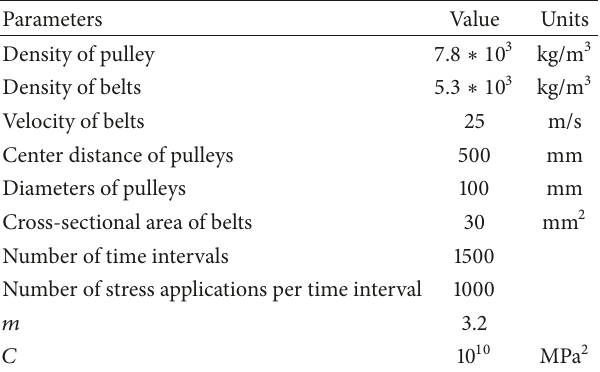
Table 1: Geometric parameters and the material parameters.